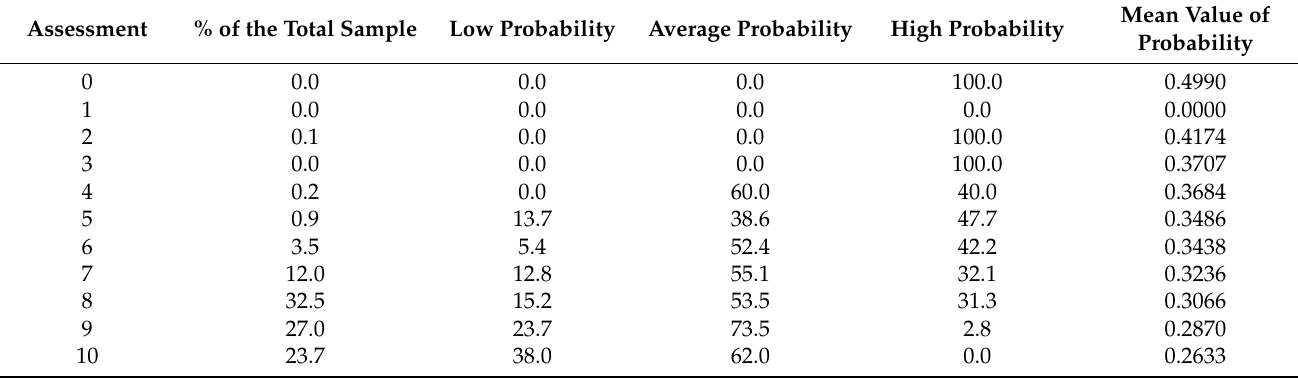
Table 7. The relationship between an assessment of the conservation of the natural heritage and the estimated probability of visiting the Monfragüe